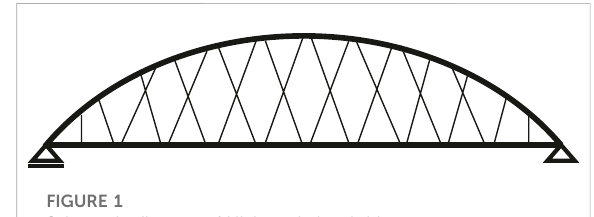
FIGURE 1 Schematic diagram of Nielsen – Lohse